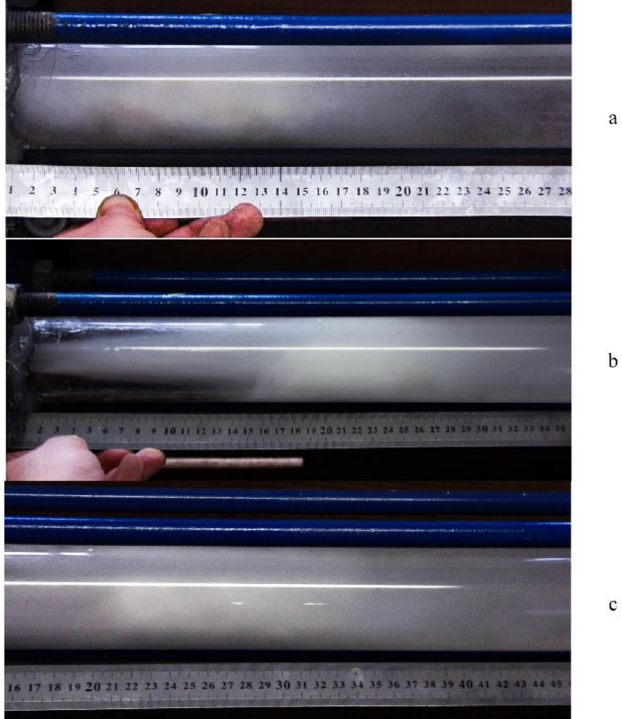
Fig. 10. Comparison of cavitation length in a same fl ow of 24 m 3 /h between (a) a single ­ -hole ori fi ce with a two-sided sloped edge, (b) a multi-hole ori fi ce and (c) a single-hole ori fi ce with a one-sided sloped edge.